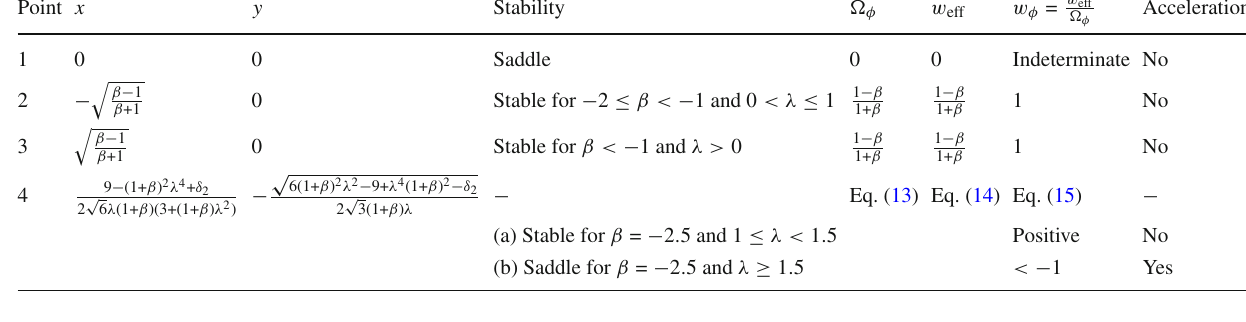
Table 2 We present stationary points and their stability for the coupling Q = β ˙ ρ φ Point x y Stability